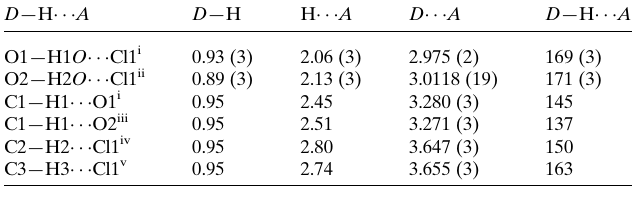
Table 1 Hydrogen-bond geometry (A˚ , (cid:4) ).